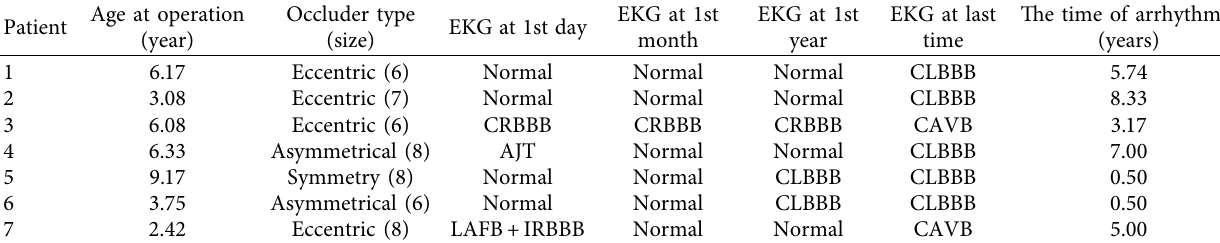
Table 5: Clinical data of patients with late-onset serious